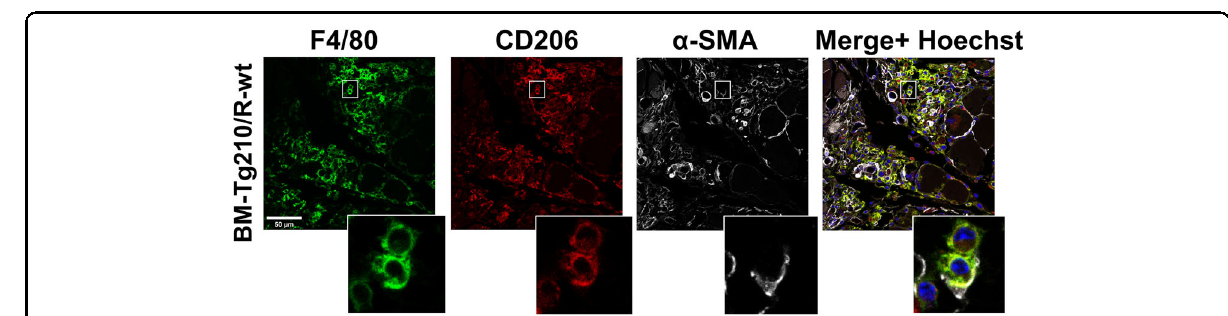
Fig. 6 BM-Tg210/R-wt ischemic muscles display α -SMA expressing macrophages. Representative images of triple immuno fl uorescence staining for F4/80 (green), CD206 (red), α -SMA (white) of ischemic gastrocnemius muscles sections of BM-wt/R-Tg210 and BM-Tg210/R-wt mice. The merge include Hoechst (blue) nuclear staining. Representative images are presented as Maxprojections. Magni fi cation 63 × 0.5, calibration bar 50 µm. Insets show magni fi cations of the indicated